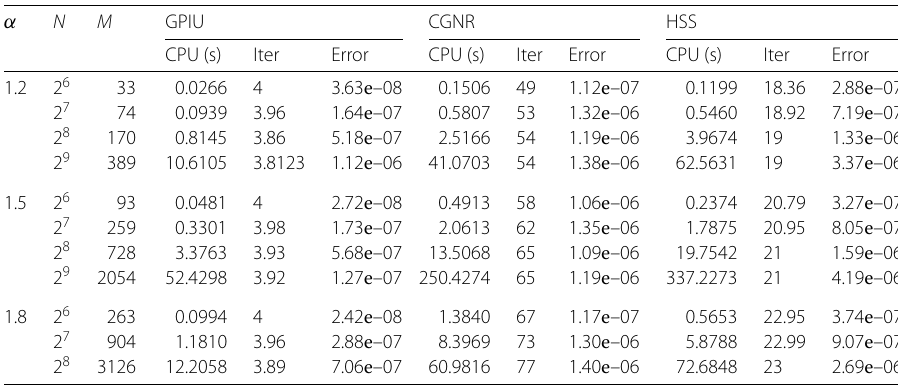
Table 2 Comparing results to solve Example 1 by the GPIU algorithm with ω = 1, δ = 0.99 and s = 0.01, and the CGNR method for α = 1.2, 1.5 and